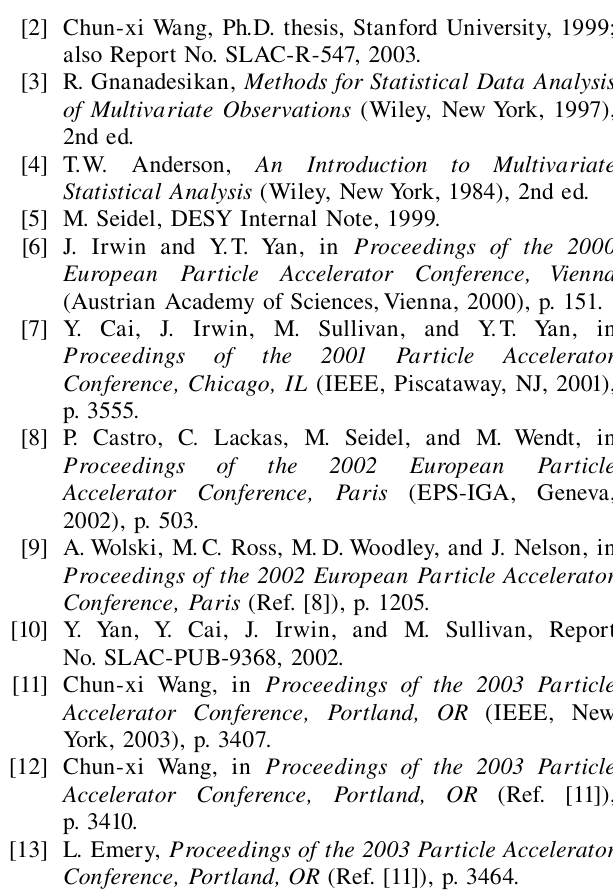
FIG. 7. (Color) Comparison of beta functions measured using SVD modes and rotated SVD modes. Black crosses are from SVD modes using 186 BPMs, blue dots are from rotated modes using 186 BPMs, red crosses are from SVD modes using 50 BPMs, and green circles are from rotated modes using 50